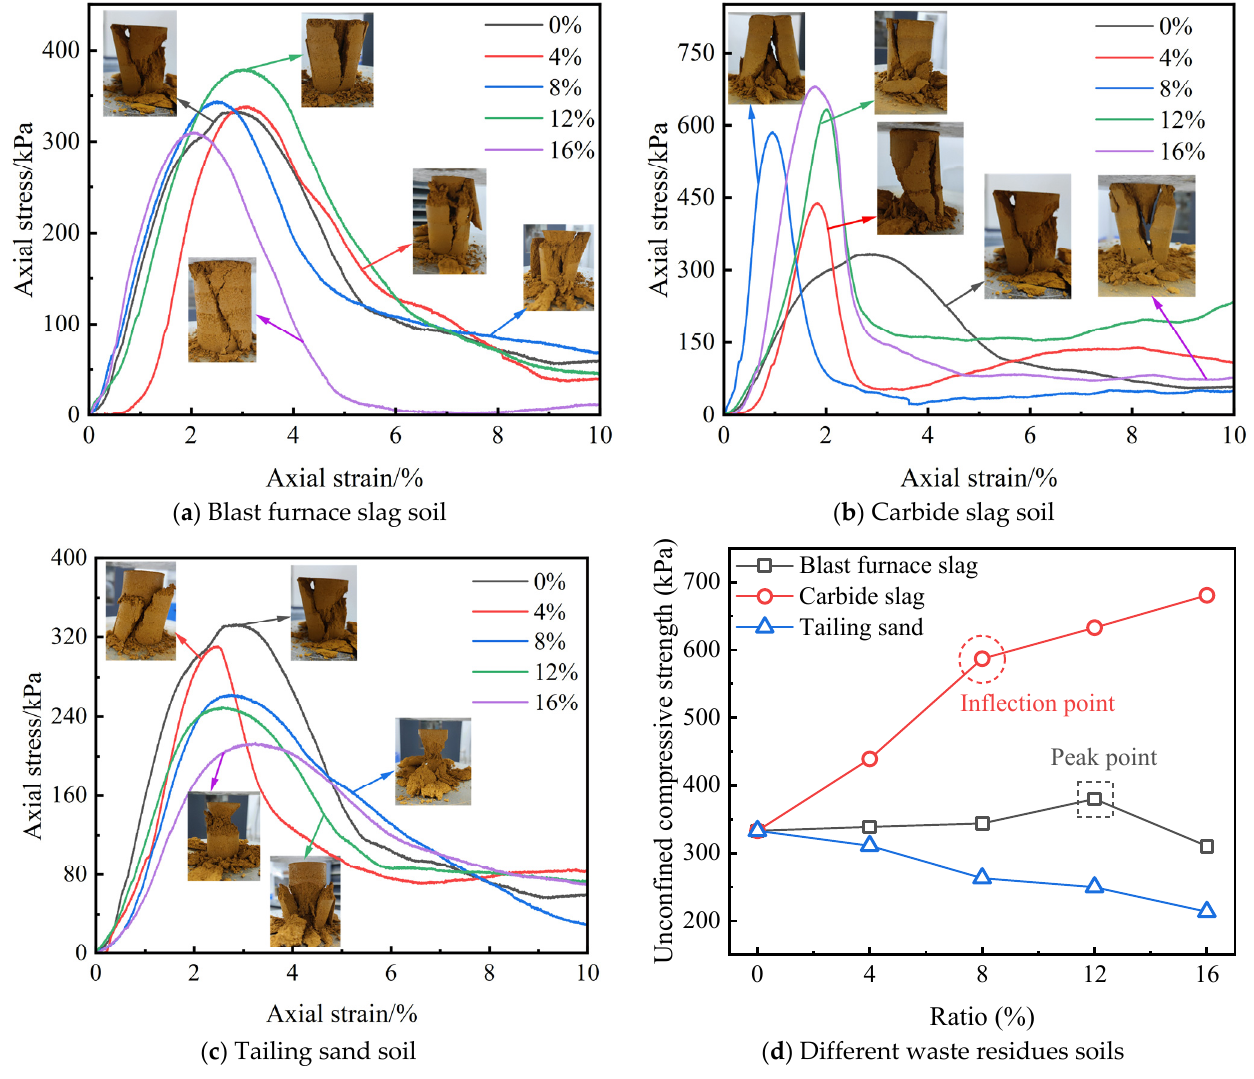
Figure 5. Unconfined compressive strength of different waste residues soils.